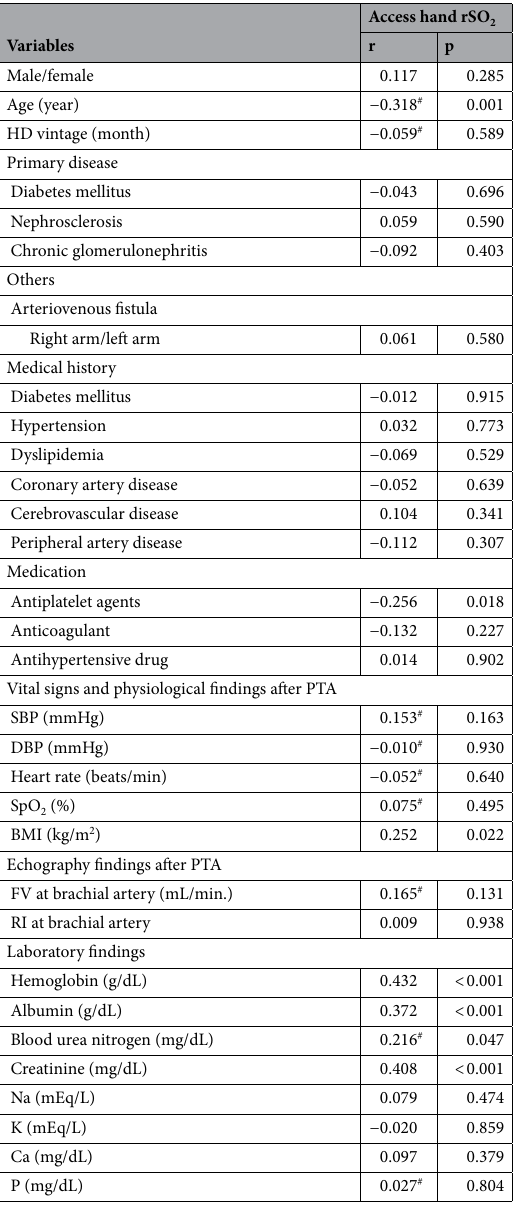
Table 2. Correlation between clinical parameters and access hand rSO 2 . Categorical data are presented as number (%), continuous data are presented as mean ± standard deviation. HD hemodialysis, SBP systolic blood